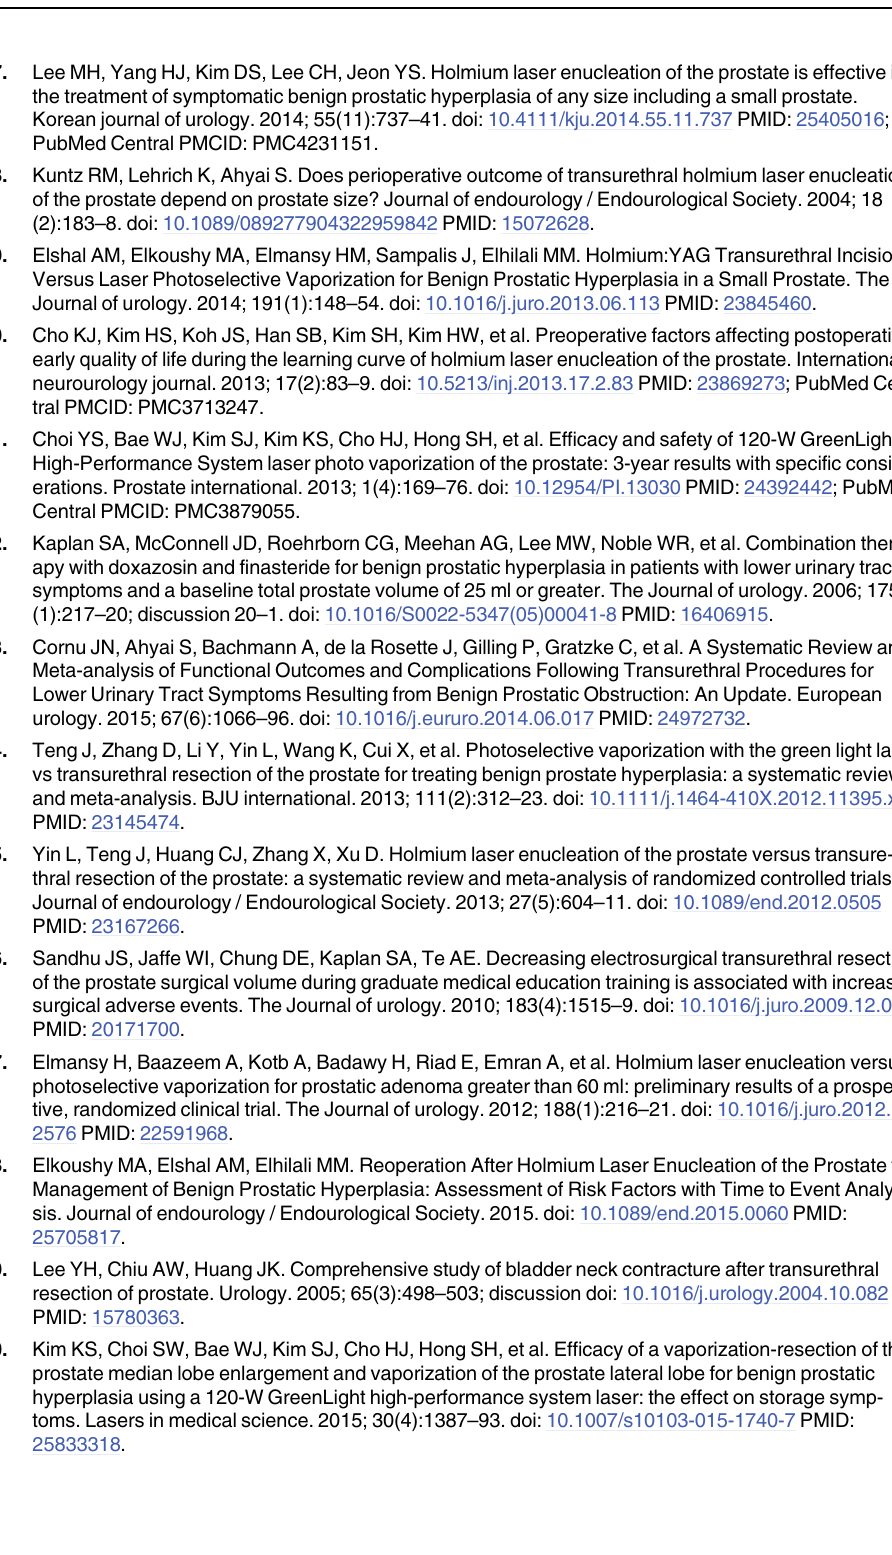
PLOS ONE | DOI:10.1371/journal.pone.0156133 May 26,